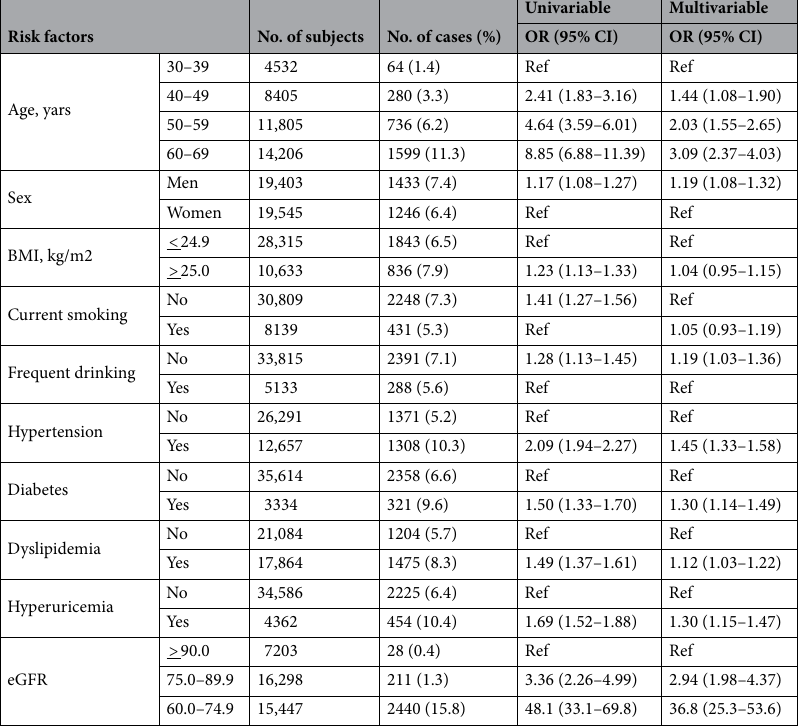
Table 2. Odds ratios and 95% confidence interval of 5-year incidence of CKD for each risk factor. The odds ratios and 95% confidence intervals of 5-year incidence of CKD for each risk factors using logistic regression analysis. In multivariable model, the odds ratios were adjusted for the following variables: age categories, sex, body mass index categories, current smoking, frequent drinking, hypertension, diabetes, dyslipidemia, hyperuricemia, and eGFR categories. BMI body mass index, eGFR estimated glomerular filtration ratio, OR odds ratio, CI confidence